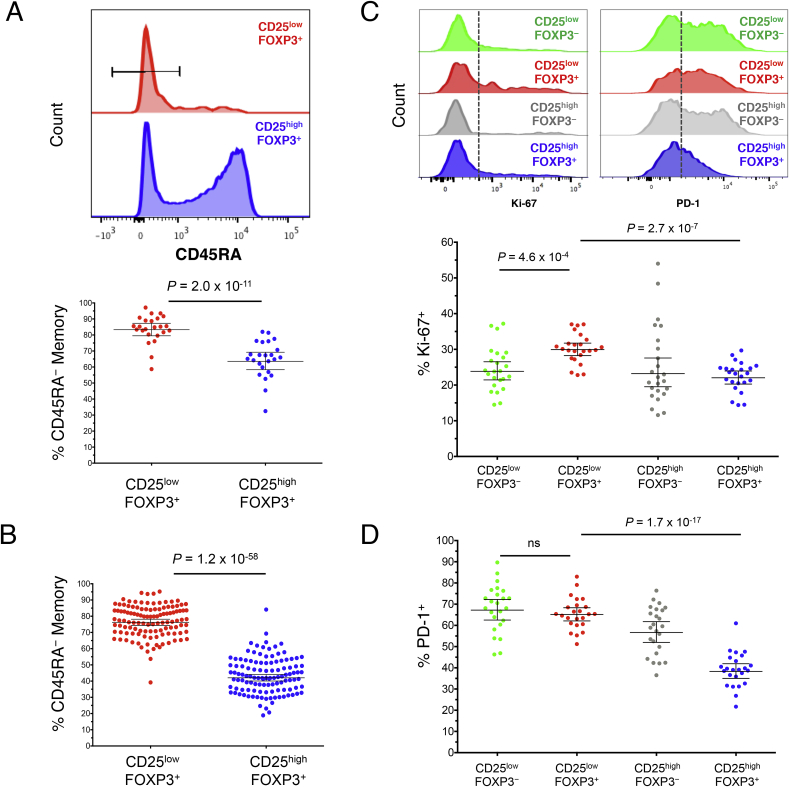
CD25lowFOXP3+T cells display a memory phenotype. (A, B) Representative histograms and summary scatter plots depict the frequency (geometric mean ± 95% CI) of CD45RA− memory T cells amongst the CD25lowFOXP3- and CD25lowFOXP3+ subsets in a population of 24 adult (median age = 42 years) healthy donors (A) or in a population of 116 younger (median age = 14 years) T1D patients (N = 62) and healthy donors (N = 54) (B). (C, D) Representative histograms and the frequency distribution (geometric mean ± 95% CI) of Ki-67+ (C) and PD-1+ (D) cells in the CD45RA− compartment of the four assessed immune subsets. P values were calculated using two-tailed paired t-tests comparing the frequency of the assessed immune subsets from the same individual. P values < 0.005 were considered significant (Bonferronni correction for the comparison of ten independent immune markers between CD25lowFOXP3+ and CD25highFOXP3+ T cells). Gating strategy to delineate: (i) CD127lowCD25lowFOXP3− (highlighted in green), (ii) CD127lowCD25lowFOXP3+ (highlighted in red), (iii) CD127lowCD25highFOXP3− (highlighted in grey), and (iv) CD127lowCD25highFOXP3+ (highlighted in blue) CD4+ T cells is depicted in Fig. 2A.